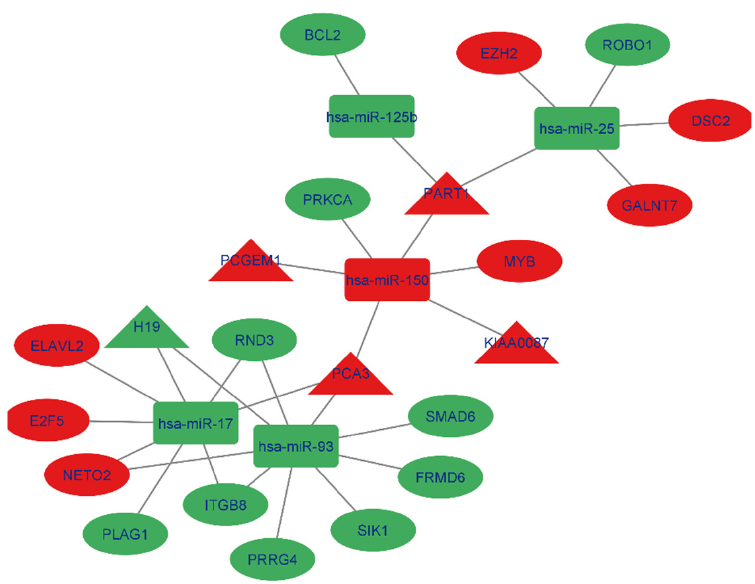
Figure 18. Red nodes signify a strong expression level, while green nodes signify a low level of expression. Ellipses signify protein-coding genes; rectangles signify miRNAs; triangles represent lncRNAs; gray edges specify lncRNA–miRNA–mRNA interactions.